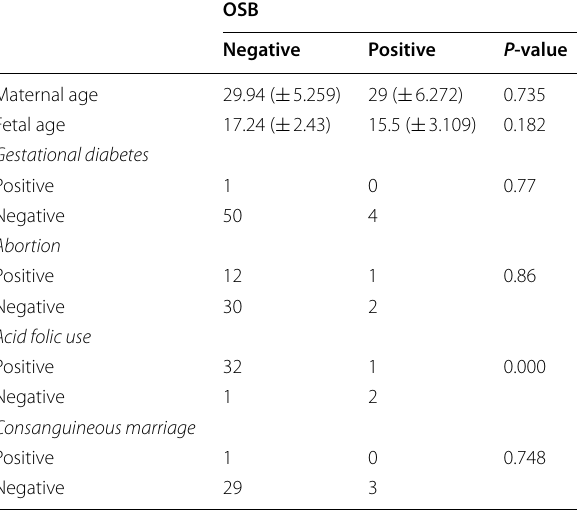
Table 4 Relation between OSB and qualitative